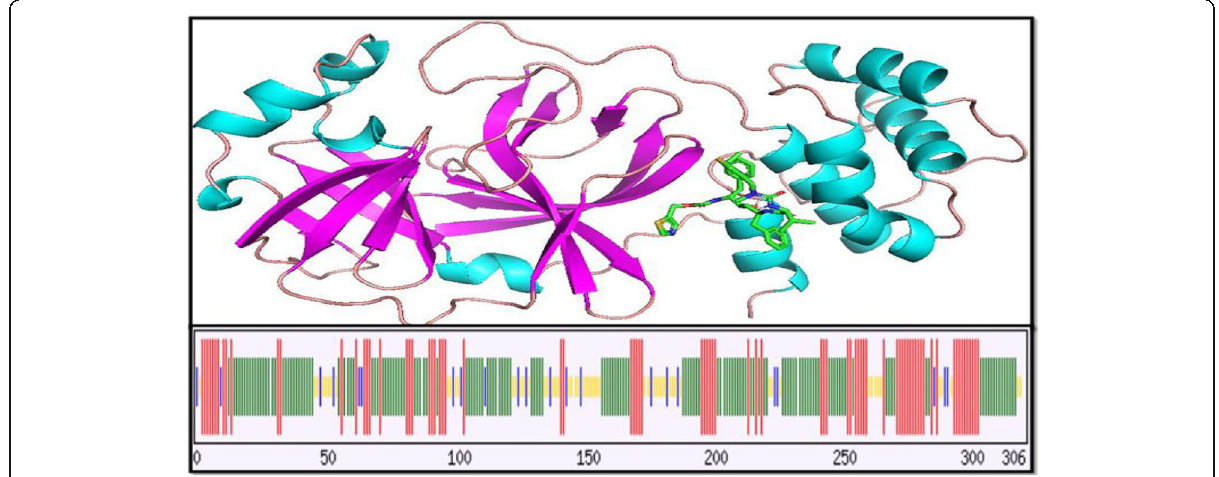
Fig. 9 The target protein secondary structures with bound lopinavir. At the top is the secondary structure visualization on pymol with regions making up the alpha helix, beta sheets, and loops shown in light blue, purple, and brown, respectively. Below is the prediction by CFSSP where the red, green, yellow, and blue lines depict regions of the helices, sheets, turns, and coils (loops), respectively. The predicted secondary structure composition shows a high degree of alpha helix and beta sheets, respectively, occupying 45 and 47% of the total residues with the percentage loop occupancy at